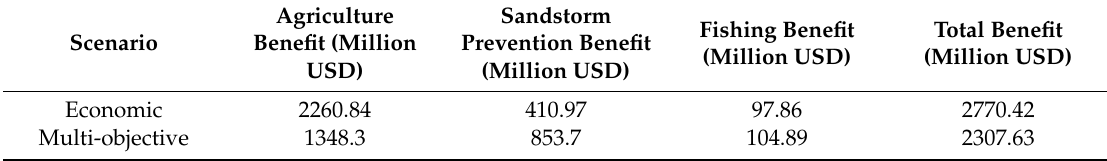
Table 5. Comparison of di ff erent section Benefits for three